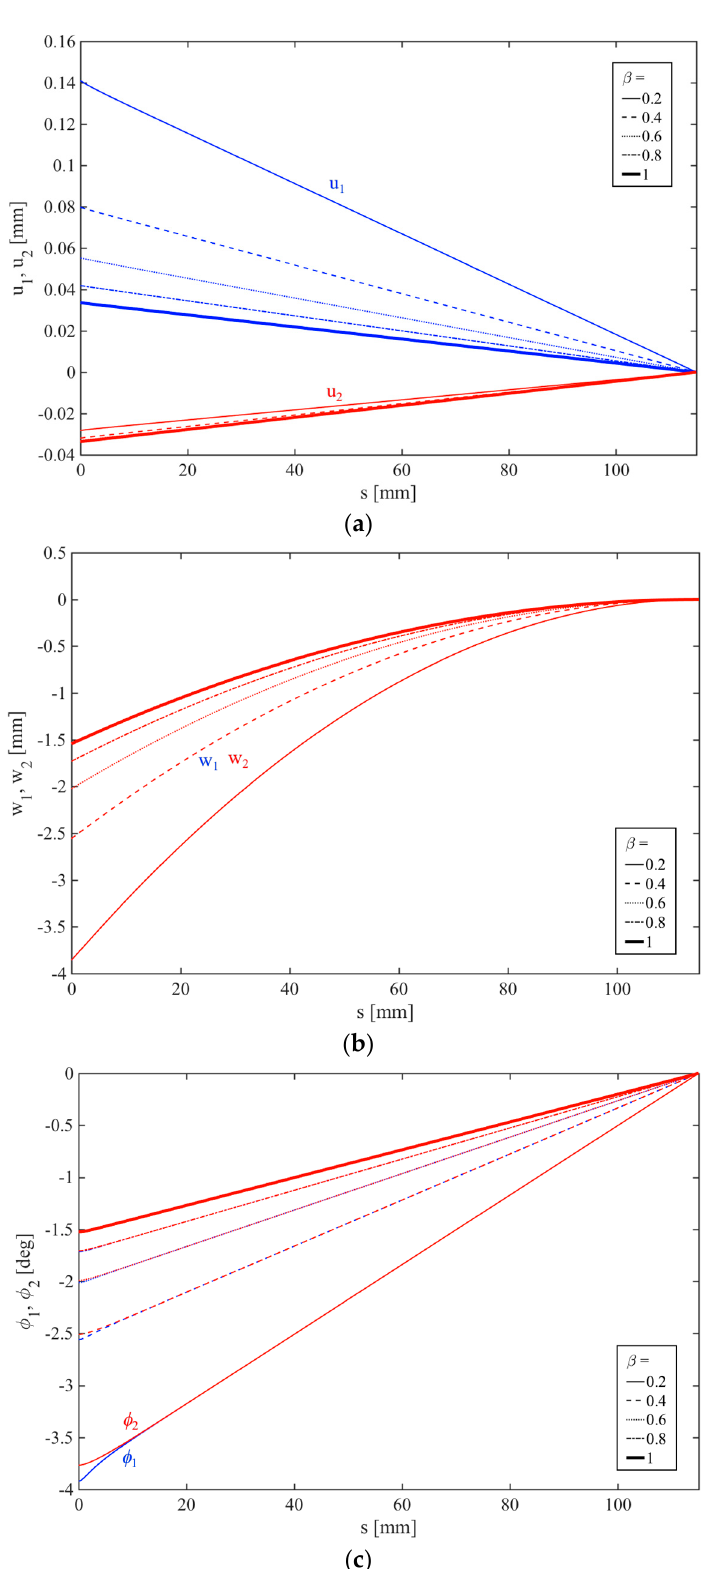
Figure 19. Effect of the mechanical ratio β on the kinematic response of the sublaminates: ( a ) Axial displacement; ( b ) Shear displacement; ( c ) Cross-sectional rotation. (Isotropic specimen).